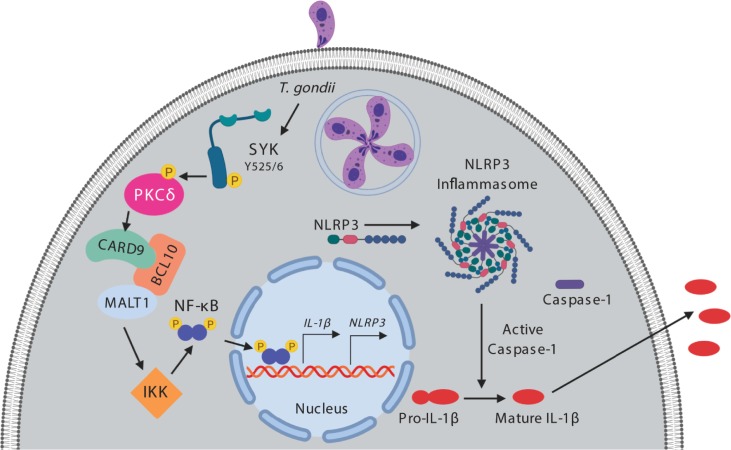
Model for T. gondii-induced IL-1β production in primary human monocytes.T. gondii infection induces phosphorylation and activation of Syk at tyrosine 525/6 (Y525/6). Syk activation subsequently leads to the phosphorylation of PKCδ, which activates the CARD9/BCL10/MALT1 complex and downstream IKK. This leads to phosphorylation of the p65 subunit of NF-κB and the translocation of NF-κB into the nucleus where it initiates transcription of IL-1β and NLRP3. NLRP3 then associates with ASC and caspase-1 to form the canonical NLRP3 inflammasome. Pro-caspase-1 is cleaved into activate caspase-1, which then cleaves pro-IL-1β to mature IL-1β. The mature, bioactive IL-1β exits the cell by an unknown mechanism, independent of pyroptosis, gasdermin D, or pore formation in the plasma membrane.